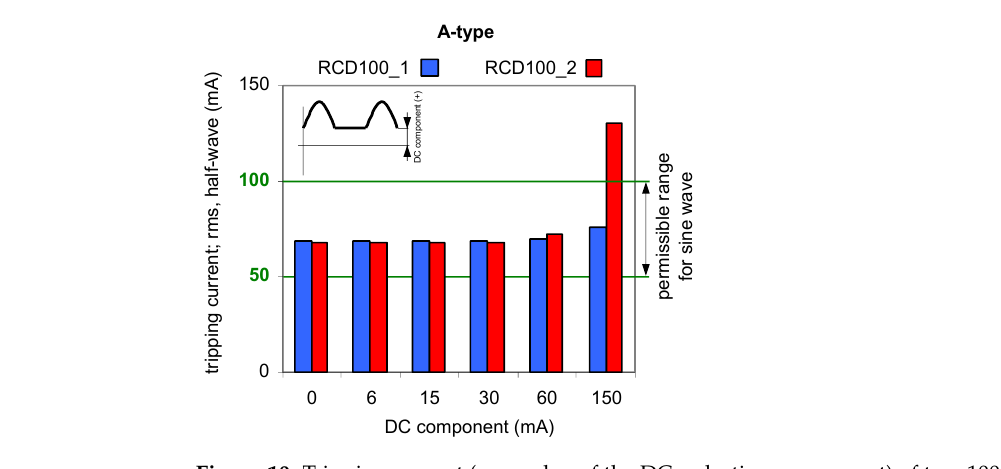
Figure 9. Tripping current (rms value of the DC pulsating component) of three 30 mA A-type RCDs under pulsating DC (half-wave) current superimposed by smooth DC component of values 6, 15, 30, 60, and 150 mA. Both components have positive (+) polarity.